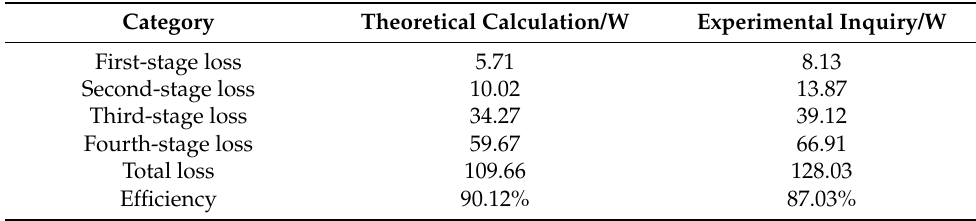
Figure 12. Voltage drop and current of power converter transistor at all stages. ( a ) First-stage transistor voltage drop, current. ( b ) Second-stage transistor voltage drop, current. ( c ) Third-stage transistor voltage drop, current. ( d ) Fourth-stage transistor voltage drop, current. Table 5. Four-stage HDCPLN experiment and theoretical power loss